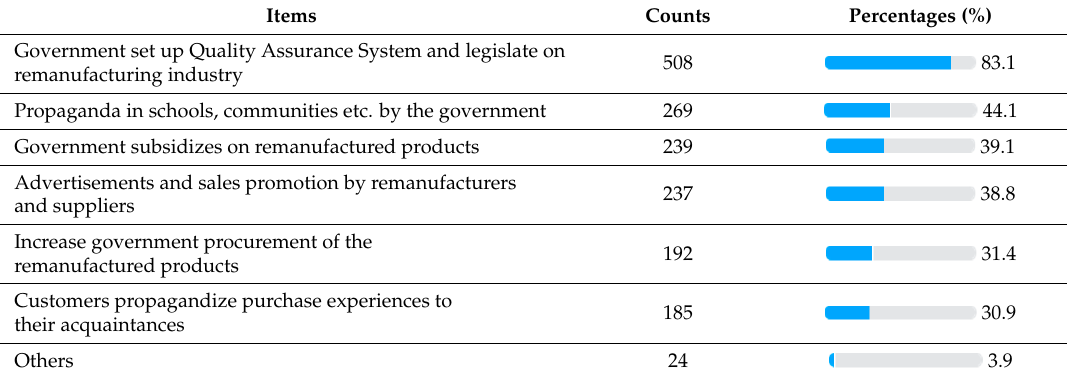
Table 5. Measures to propagandize remanufactured products.